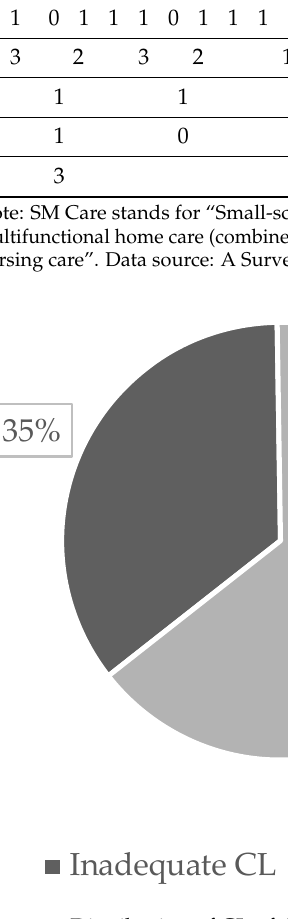
Figure 6. Distribution of CL of the current long-term care recipients ( n = 652). Data source: A Survey on Older Adults of Sakai City (2019) [20].